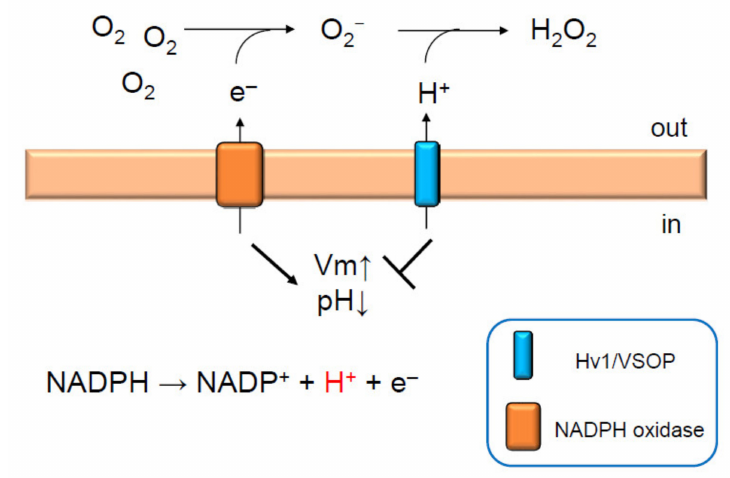
Figure 1. Hv1/VSOP maintains NADPH oxidase activity in neutrophils. Activation of NADPH oxidase depolarizes membrane potential. This is dampened by the activation of Hv1/VSOP, which compensates for charge imbalance [22]. Protons released into the cytoplasm upon NADPH oxidase activation are extruded by Hv1/VSOP outside the cell or into phagosomes to produce H 2 O 2 and to maintain neutral phagosomal pH [22]. Thus, Hv1/VSOP has dual functions; inhibition of membrane depolarization and acidification of cytoplasm by extruding protons. Both lead to sustained ROS production by NADPH oxidase [12,22,26,28]. Arrow and T arrow indicate promotion and inhibition, respectively, for Vm and